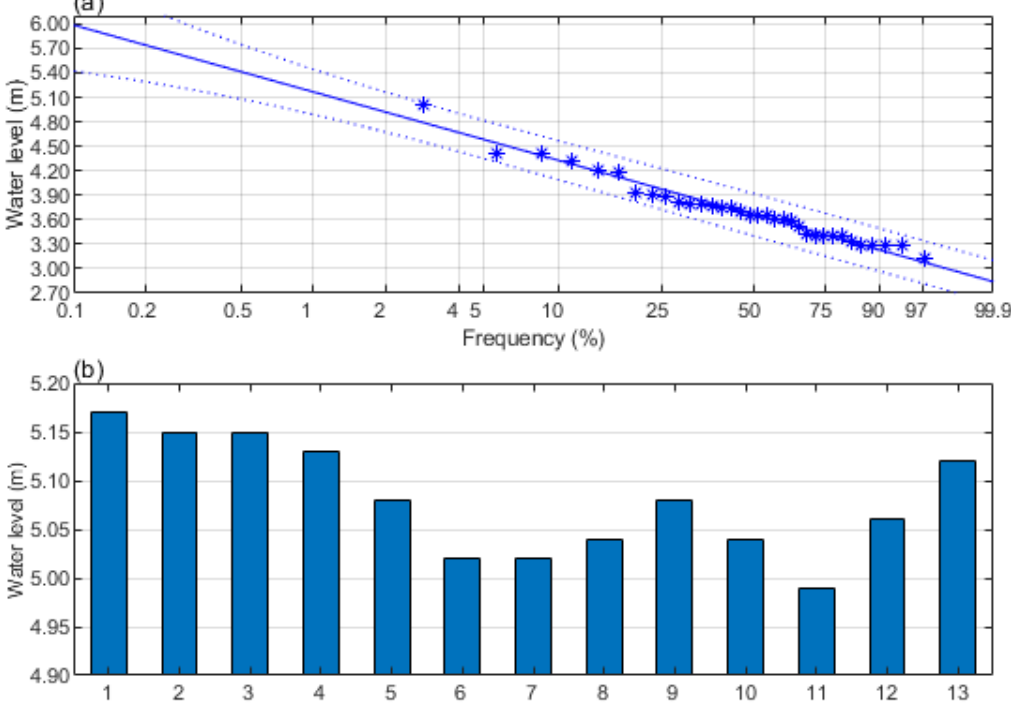
Figure 5. ( a ) Fitted lines of maximum tidal levels for Point 1 according to the EV1 distribution. Dashed lines indicate 95% confidence intervals. ( b ) Tidal levels for the 100-year period for all 13 points. Table 4. Mean, standard division, scale, and location parameters for the 13 measuring points.